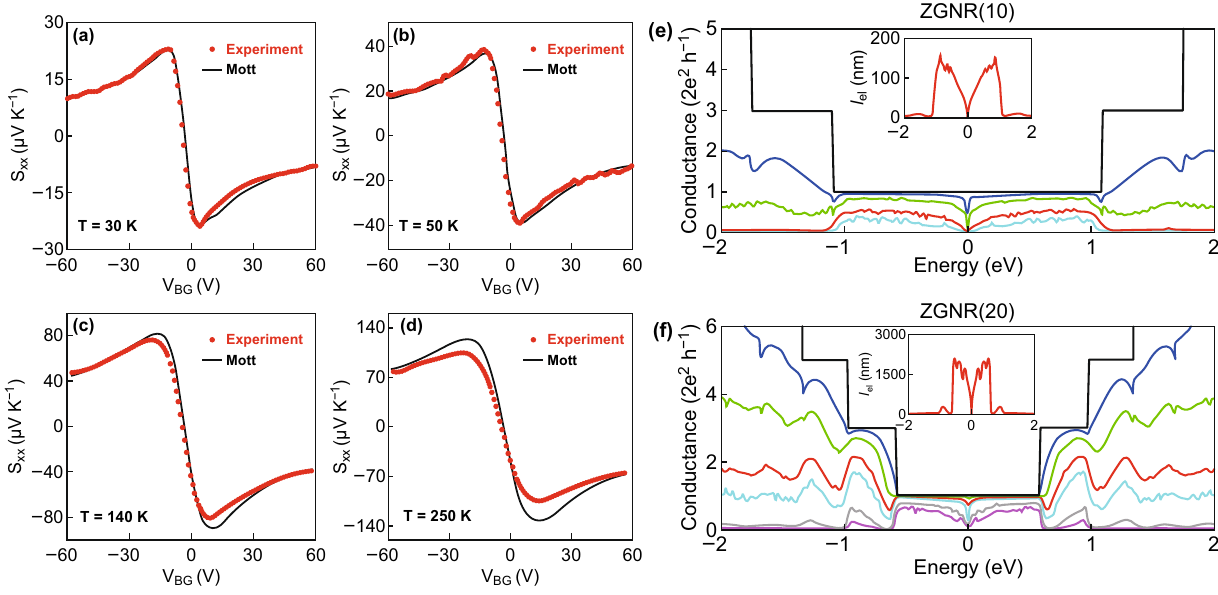
Fig. 1 The in-plane Seebeck coefficient of bilayer graphene as a function of the backgate voltage ( V BG ) at different temperatures: a T = 30 K, b T = 50 K, c T = 140 K and, d T = 250 K. Reproduced with permission from Ref. [49]. Copyright 2010, American Physical Society. Electron transport through the edge-disordered zigzag edges graphene nanoribbons: sample lengths e Nz = 10 and f Nz = 20. Reproduced with permission from Ref. [50]. Copyright 2010, American Physical